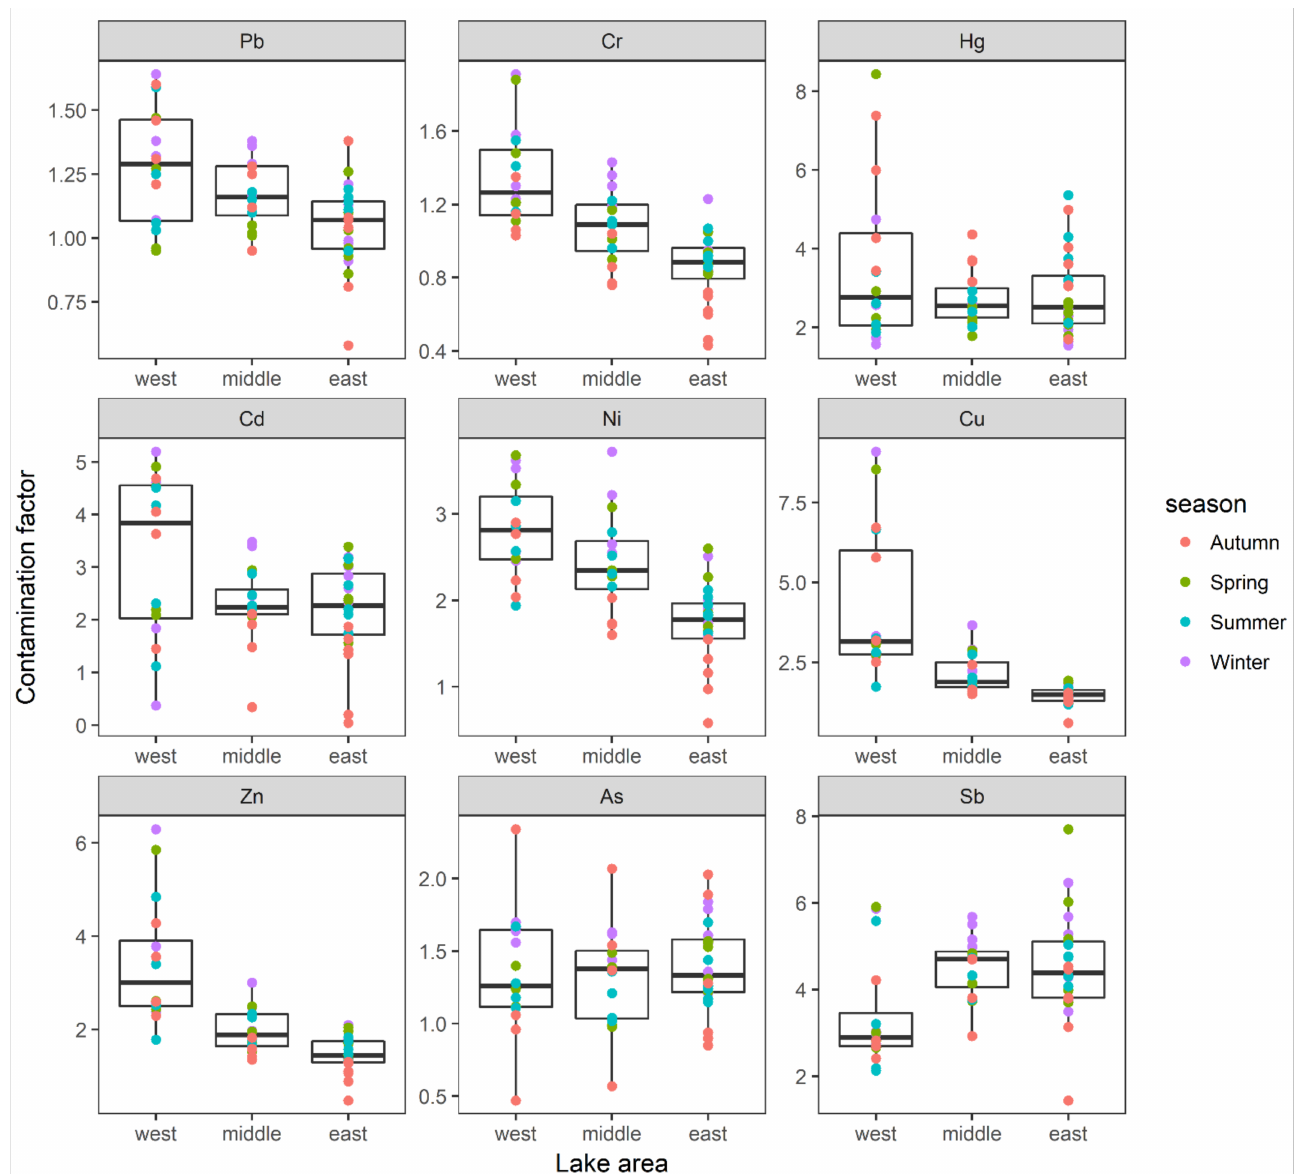
Figure 4. The spatial distributions of CF of each heavy metal were displayed in three lake areas. Boxes represent the 25th to 75th percentiles; straight lines within the boxes mark the median; and the small dots indicate the average values of the 4